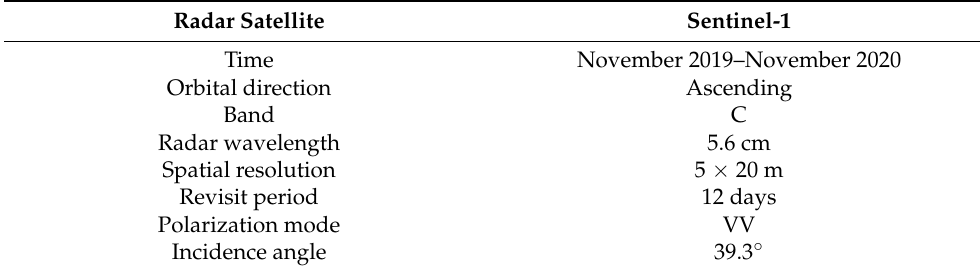
Table 3. Main parameters of Sentinel-1 SAR